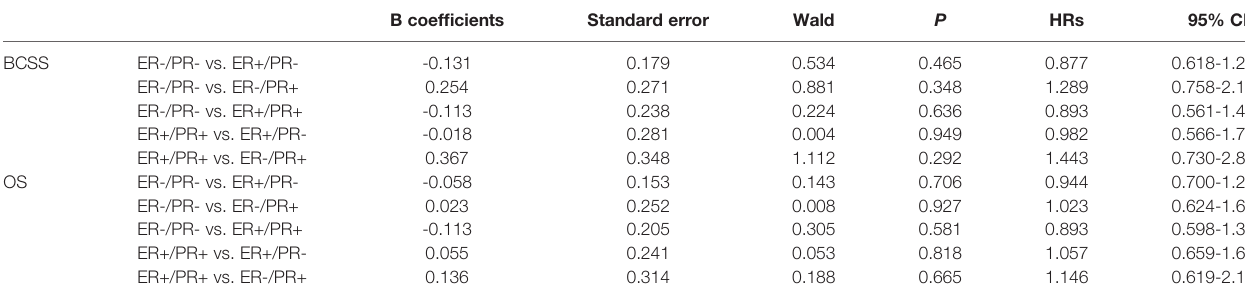
TABLE 3 | Multivariate analysis of BCSS and OS in 1561 women with HER2-negative MBC. B coef fi